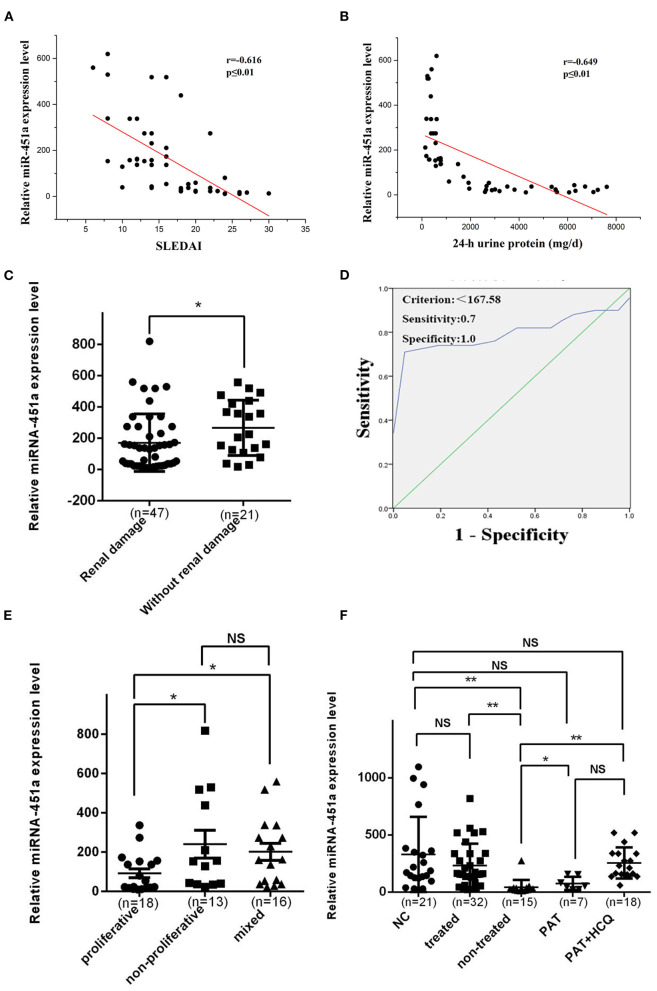
Serum exosomal miR-451a correlates with SLE disease activity and renal damage. (A) The level of serum exosomal miR-451a in patients with LN was negatively correlated with systemic lupus erythematosus disease activity index score (n = 47, r = −0.616, P < 0.01). (B) The level of serum exosomal miR-451a in patients with LN was negatively correlated with 24-h urinary protein levels (n = 47, r = −0.649, P < 0.01). (C) The miR-451a level in exosomes from 47 patients with SLE with renal damage was significantly lower than that in 21 patients with SLE without renal damage by RT-qPCR. (D) Diagnostic utility of serum exosomal miR-451a to differentiate patients with SLE and renal damage from patients with SLE without renal damage. and the area under the ROC curve was 0.801 (95% confidence interval, 0.7–0.902; P < 0.001). (E) The expression level of miR-451a in renal proliferative type (n = 18) was lower than in non-proliferative type (n = 13), and the expression level of miR-451a in mix type (n = 16) was in the middle. (F) The expression level of exosomal miR-451a in SLE patients after treatment (n = 32) was significantly higher than that in those without treatment (n = 15). Treatment with traditional drugs, including glucocorticoid (n = 7) and hydroxychloroquine, increased the expression level of exosomal miR-451a. *P < 0.05, **P < 0.01, NS, no significance.